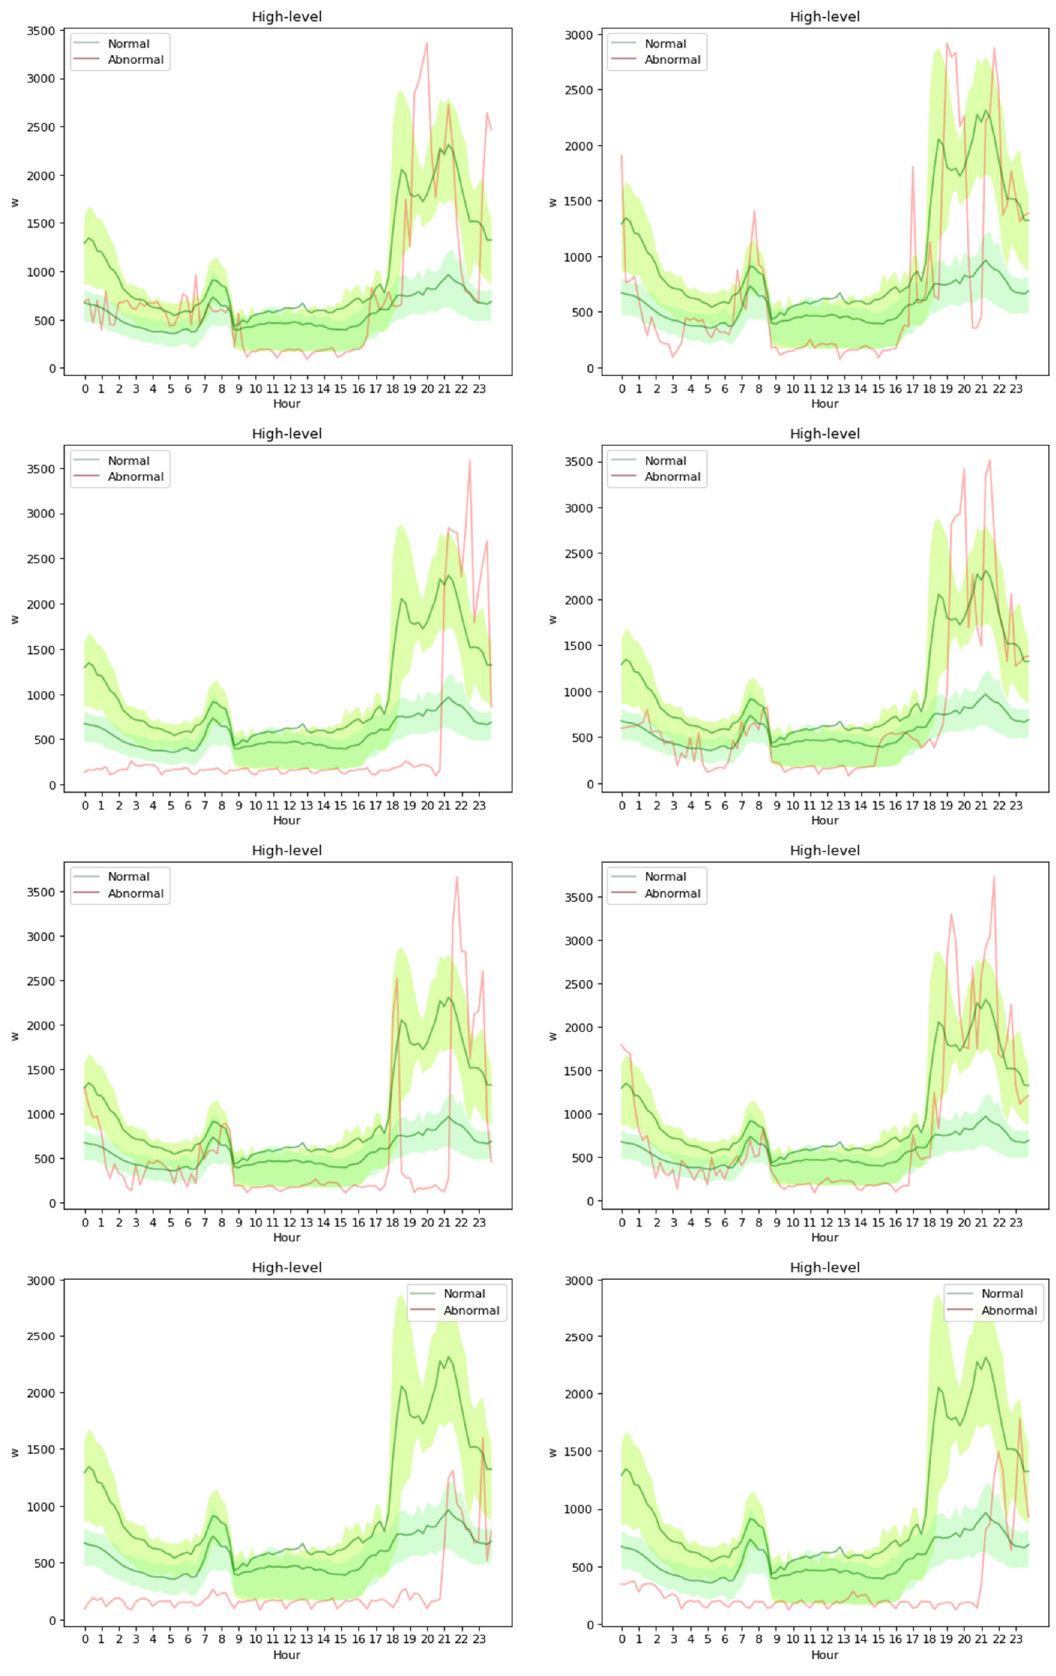
Figure A8. Load profiles of each abnormal electricity consumption events of User 04 using the high-level features.